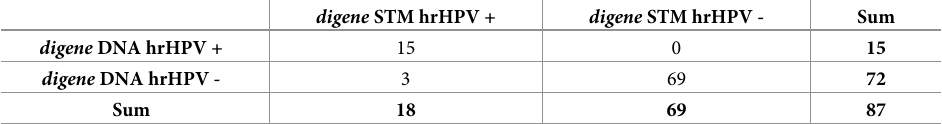
Table 1. digene HC2 High-Risk HPV assay performance on a set of 87 paired, self-collected vaginal samples. One set of samples was collected using a digene brush resuspended in digene Specimen Transport medium (“ digene STM”), and the second set was extracted DNA from swabs suspended in tubes with lysis/stabilization buffer (“ digene DNA”). Samples were considered to be HPV positive if the RLU ratio was 1 or more, as instructed in the digene protocol. digene STM hrHPV + digene STM hrHPV - Sum digene DNA hrHPV + 15 0 15 digene DNA hrHPV - 3 69 72 Sum 18 69 87